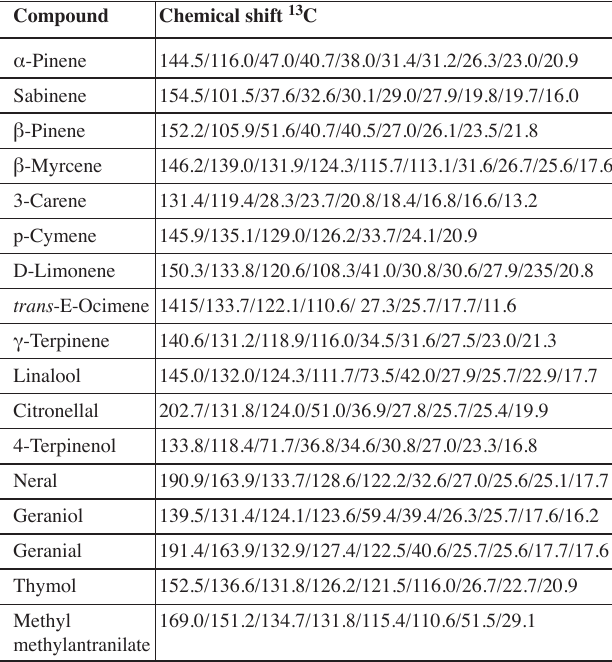
Tab. 5: Chemical shifts ( 13 C) of compounds in Citrus spp. petitgrains